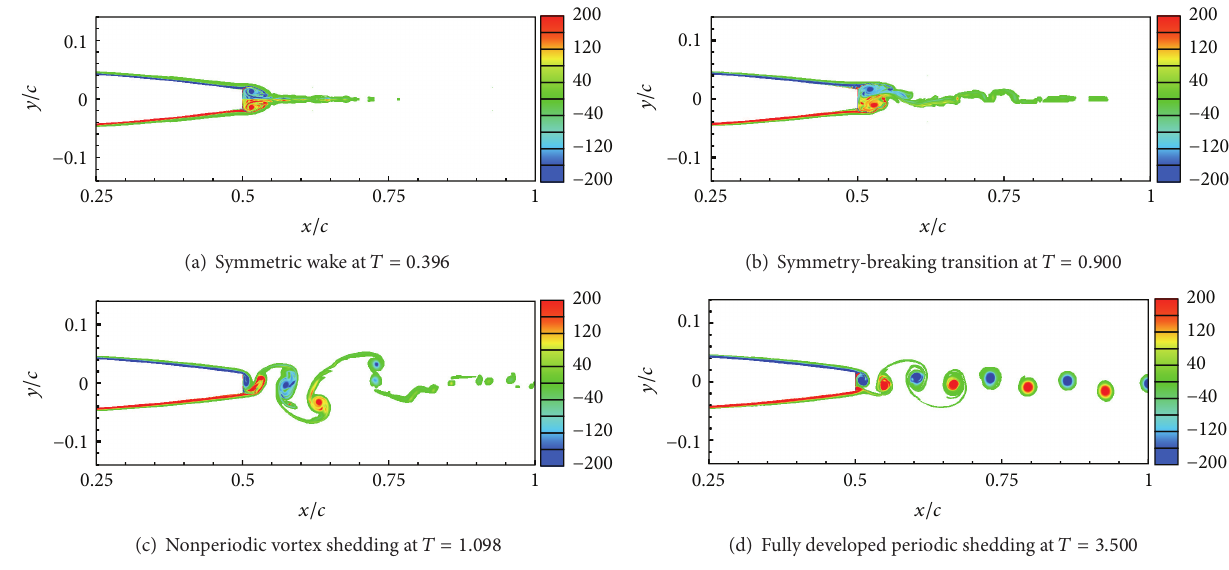
Figure 3: Wake patterns of the NACA 0009 hydrofoil with a truncated trailing-edge ( 𝛽 = 0 ∘ ) for Re = 10 6 .